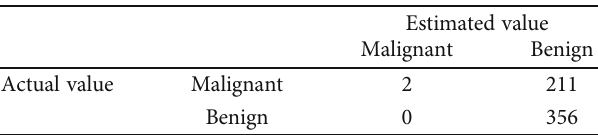
Figure 13: Success percentages of the K -means technique. Table 8: Complexity matrix of the hierarchical clustering technique.